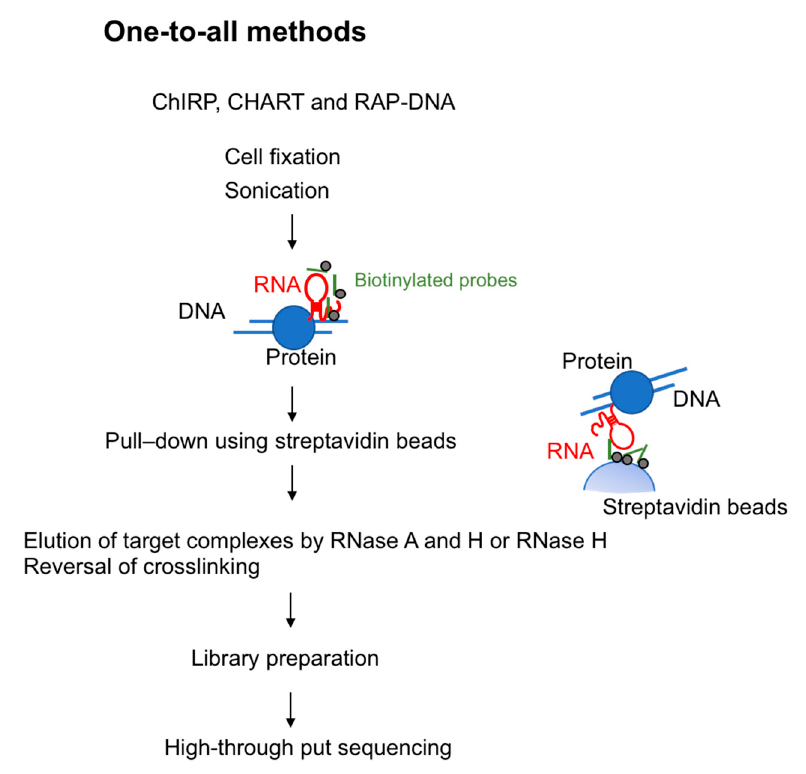
Figure 1. Overview of one-to-all methods to capture RNA-interacting genomic loci. Chromatin Isolation by RNA Purification (ChIRP), Capture Hybridization Analysis of RNA Targets (CHART), and RAP-DNA (RNA antisense purification) use biotinylated probes for the target RNA. After the chromatin fraction is pulled down by the use of streptavidin beads, RNase is used to elute genomic DNA. The resulting library is prepared for high-through put sequencing.